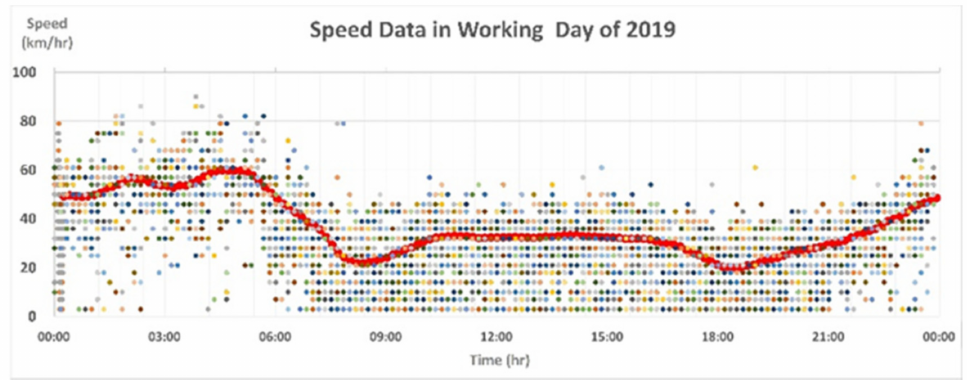
Figure 6. iTIC’s data on the traffic speed on working days in 2019.